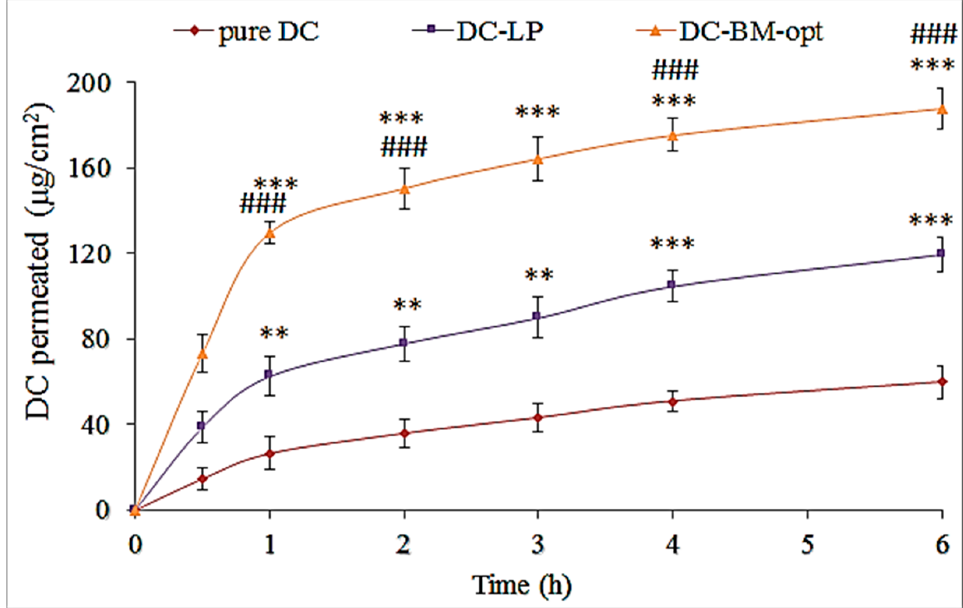
Figure 6. Permeation study of different treatment groups (pure diclofenac (DC), optimized diclo- fenac bilosomes (DC-BMs-opt), and diclofenac liposomes (DC-LP)). Study was performed in triplicate and result shown as mean ± SD. Statistical analysis performed between each group and p < 0.05 considered significant. *** highly significant to pure DC; ### significant to DC-LP; ** significant to pure DC.